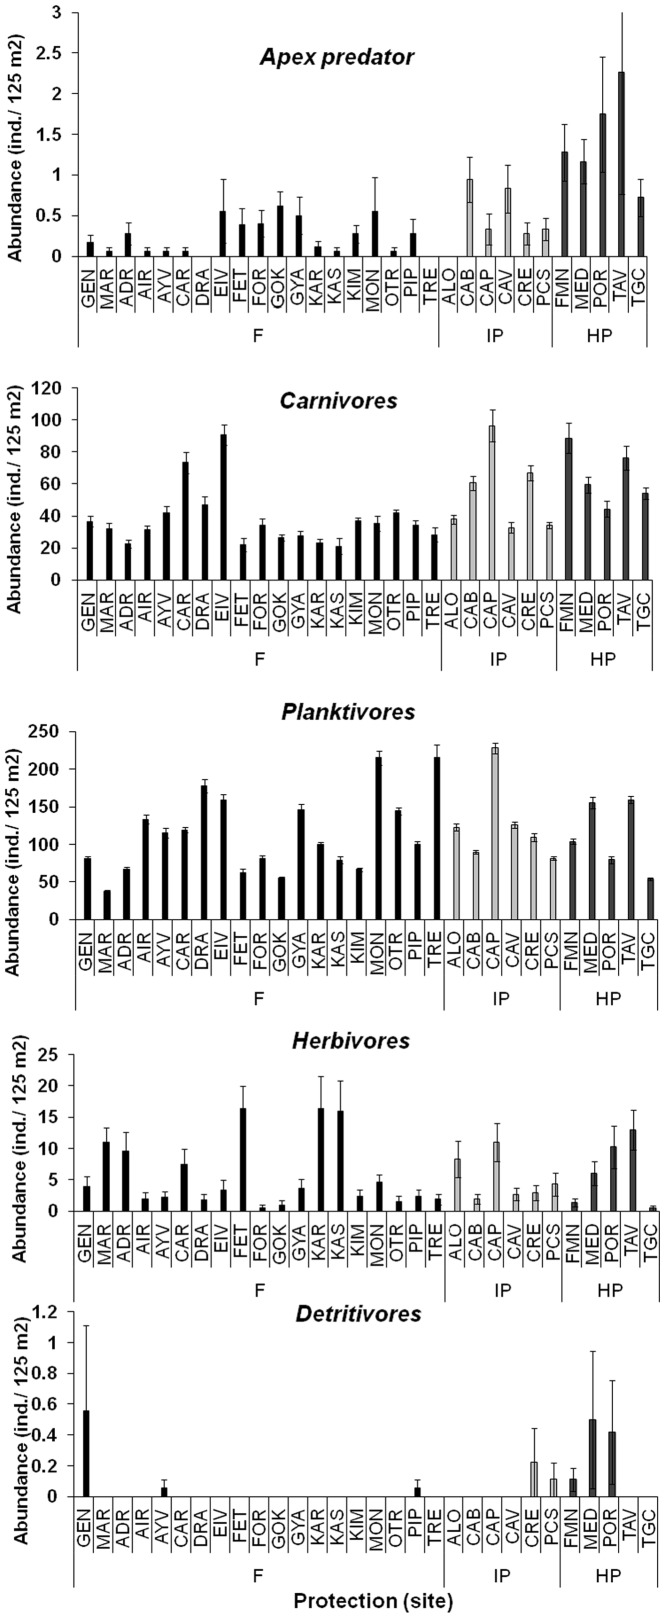
Mean values (± SE) of density per transect per each trophic group at each sampling site (see Figure 1 for complete site names).Black bars indicate fished areas (F), light gray bars indicate intermediate protected MPAs (IP) and dark gray bars indicate highly protected MPAs (HP).